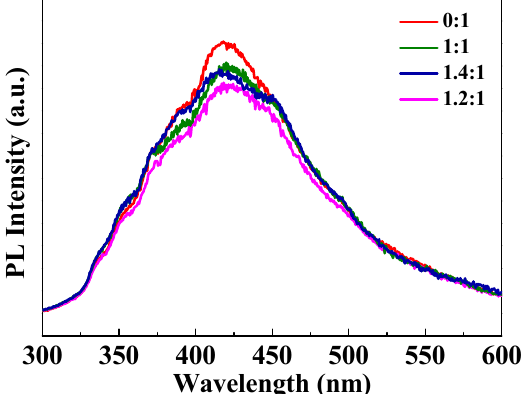
Figure 4. Photoluminescence spectra of the pure TiO 2 nanoparticles and the BaTiO 3 -TiO 2 core-shell heterostructures excited at 325 nm. The ratios in Figure are the ratio of BaTiO 3 to TiO 2 .